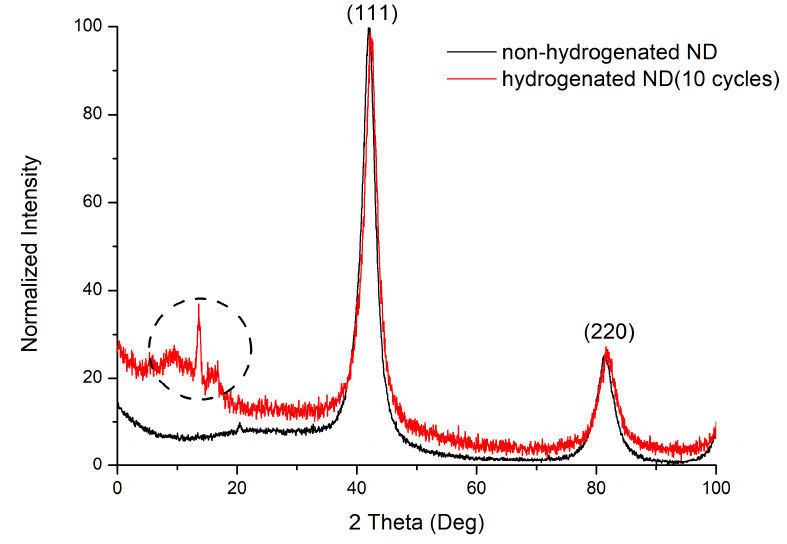
Figure 7. Diffraction pattern of non-hydrogenated and hydrogenated nanodiamonds. Raman spectra of nanodiamonds before and after hydrogenation are presented at Figure 8.